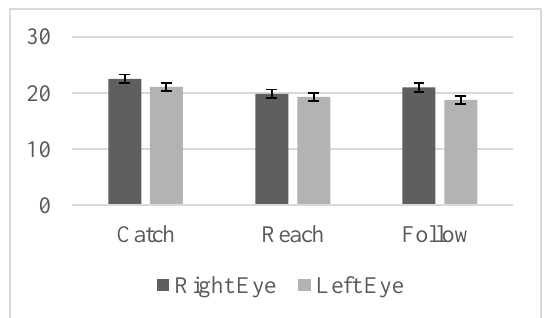
Figure 9. Left- and Right-Eye Pupil Size Differences under Both Hands Condition for